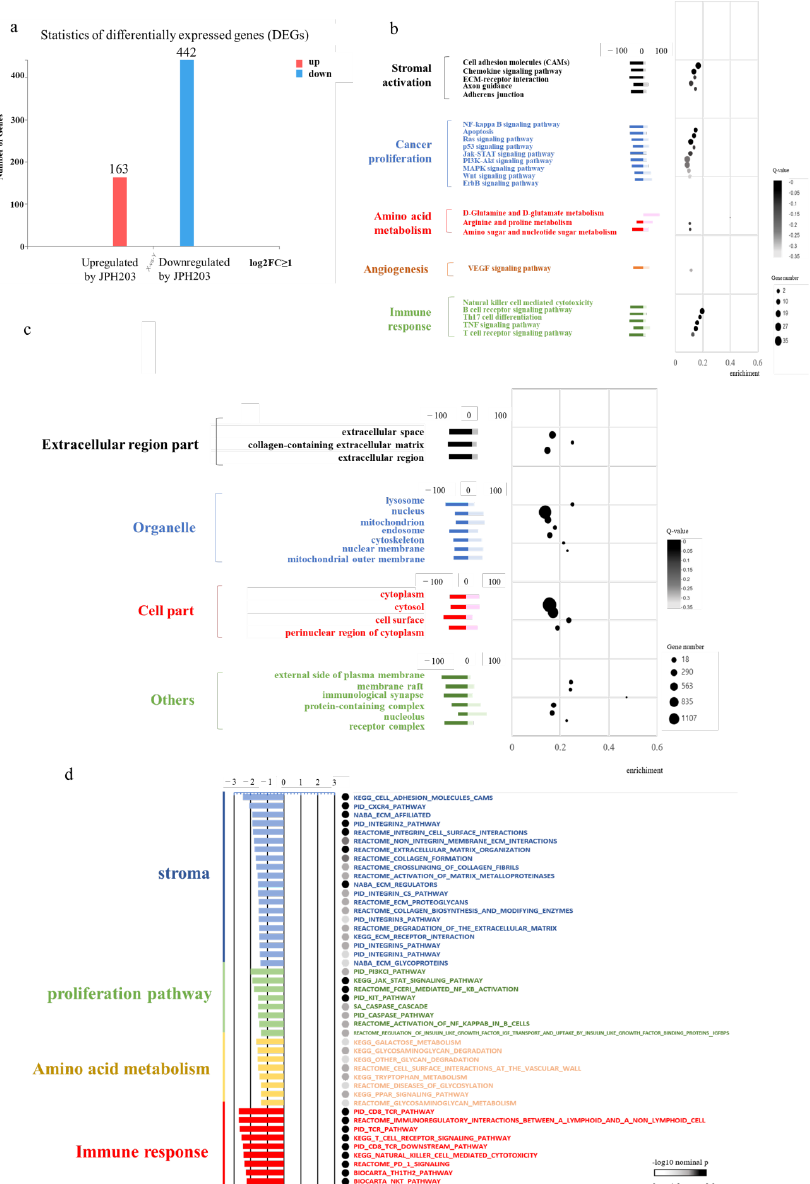
Figure 4. RNA extraction from a CT26 + MSC mouse cecal orthotopic tumor with and without JPH203. ( a ) Statistics of differentially expressed genes (DEGs). According to the gene expression